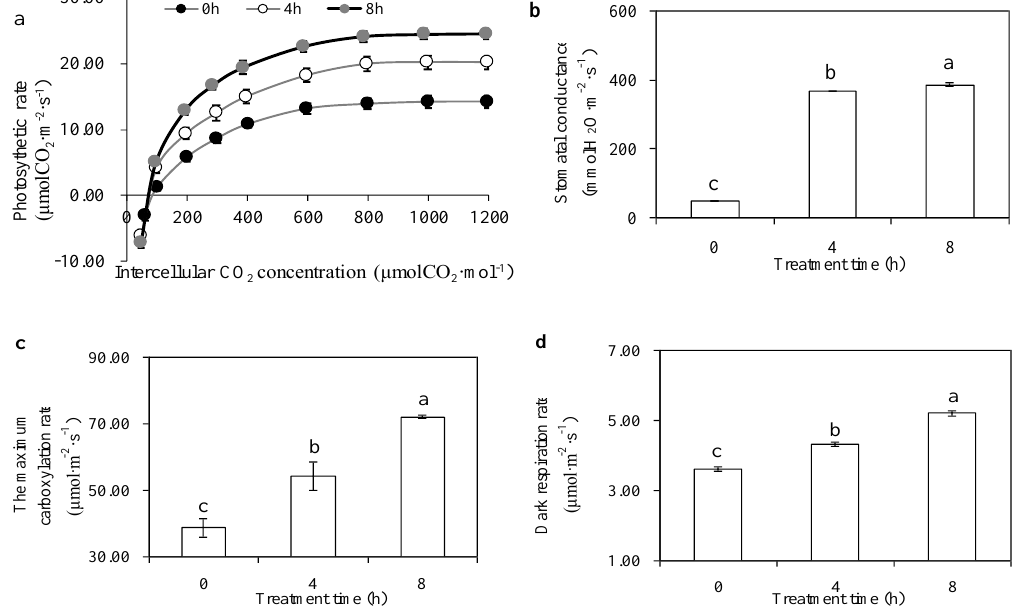
Figure 3. Effects of Gas Exchange Parameters. ( a ) P n -Ci curve, ( b ) conductance of H 2 O, ( c ) the maximum carboxylation rate, and ( d ) dark respiration rate in leaves of mulberry seedlings exposure to 4 μL·L −1 NO 2 for 0 h, 4 h (4 h·d −1 , for one day), and 8 h (4 h·d −1 , for 2 days). Date represent means of four plants ± standard deviations. Different lowercase letters for the same parameter indicate significant differences among different treatments at p < 0.05 levels.